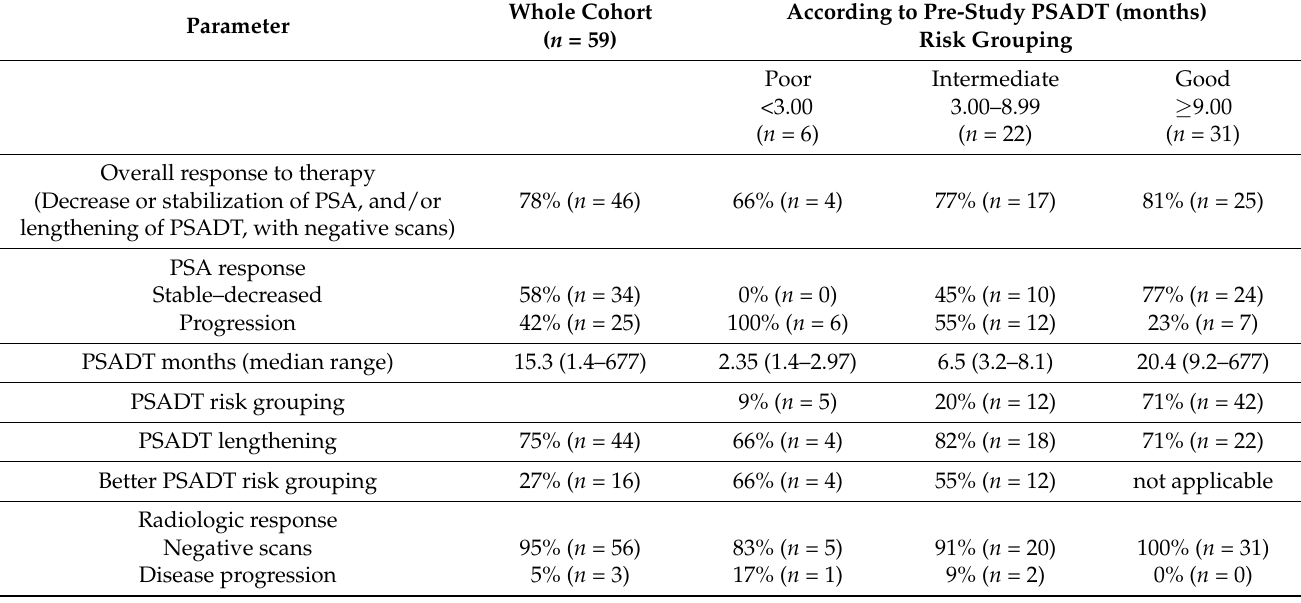
Table 2. Treatment characteristics and response at 6